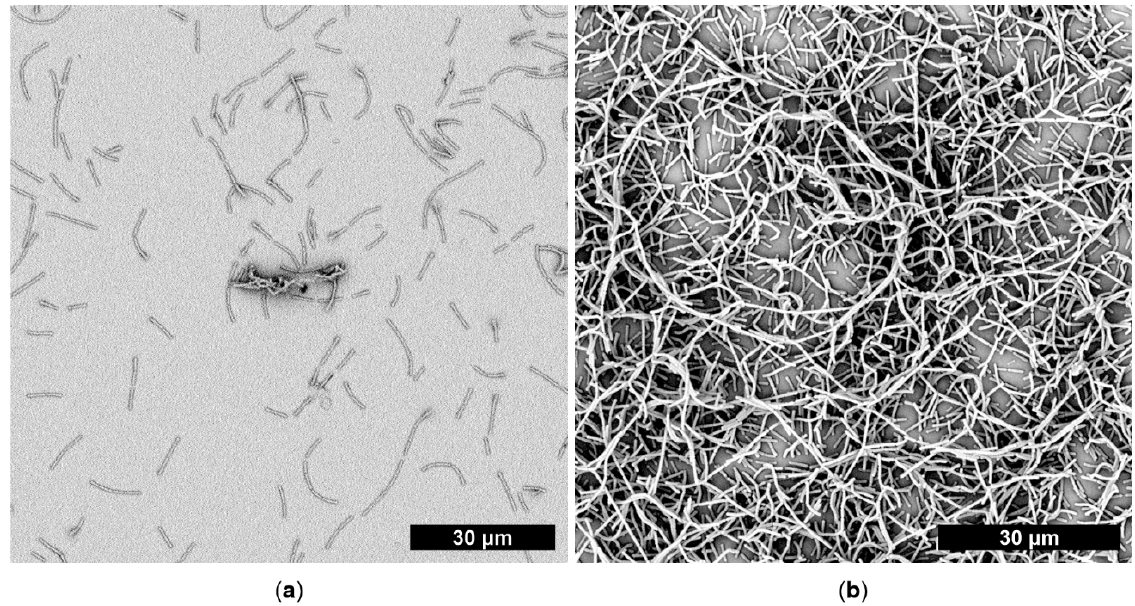
Figure 2. Scanning electron microscope images of Lactobacillus rhamnosus GG bacteria on the surface of ( a ) glass containing -SH groups (GSH) and ( b ) additionally covalently attached gold nanoparticles (GSHAu).